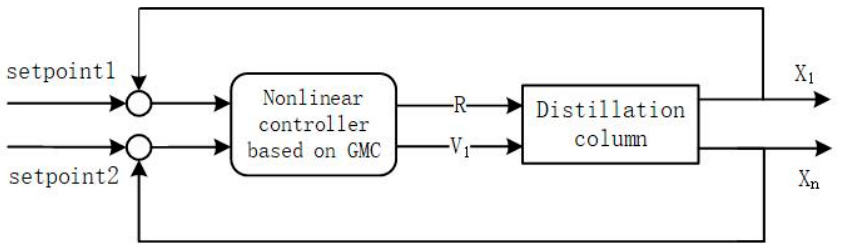
Figure 11. GMC control structure based on the proposed model.